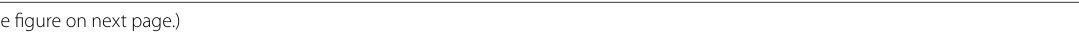
Fig. 3 ConA-induced hepatitis is controlled by Par2 activation in the immune system. A , C , and D FACS analysis of CD45.2 mice (WT and Par2KO) that were used as BM donors to reconstitute WT CD45.1 mice, indicate that T-lymphocyte distribution after BM replacement was comparable in both setups, as both CD4 and CD8 T cells comprised an average of 88% of the donor T cells ( C ), n 14. B , C , and D . The reciprocal experiment: FACS = analysis of WT CD45.1 that were used as BM donor to CD45.2 (WT and Par2KO) recipient mice. T cell distribution after BM replacement remained the same in both setups. The donor cells comprise ~81% of the T cells, n 22. Red circles indicate mice that were excluded from the experiment due = to unsuccessful BM replacement ( n 3). E , H A control experiment WT BM-reconstituted WT mice (CD45.1 into CD45.2) displays both mononuclear = cell infiltration and hepatocellular damage. Note that hepatocellular damage is apparent on day 1 ( E ). F , I Par2KO BM-reconstituted WT mice show the relatively diminished levels of infiltrates. Note that hepatocellular damage is still apparent. G , J WT BM-reconstituted Par2KO mice. Infiltrates and tissue damage are apparent, indicating that mononuclear infiltrations are mediated via Par2 on immune cells and not via Par2 signaling in the hepatic tissue. Scale bar 75μm. K Quantification of the hepatocellular damage (the percentage area of necrotic lesions) presented in E – J ( n 18, = = 3 for each group). Black—statistical significance within the same group. Red—statistical significance in comparison to control at day 1. Blue— statistical significance between the two reciprocal BM replacements. Statistical significance was measured using T test. *Indicates p <0.05, ** p <0.01, *** p <0.005, error